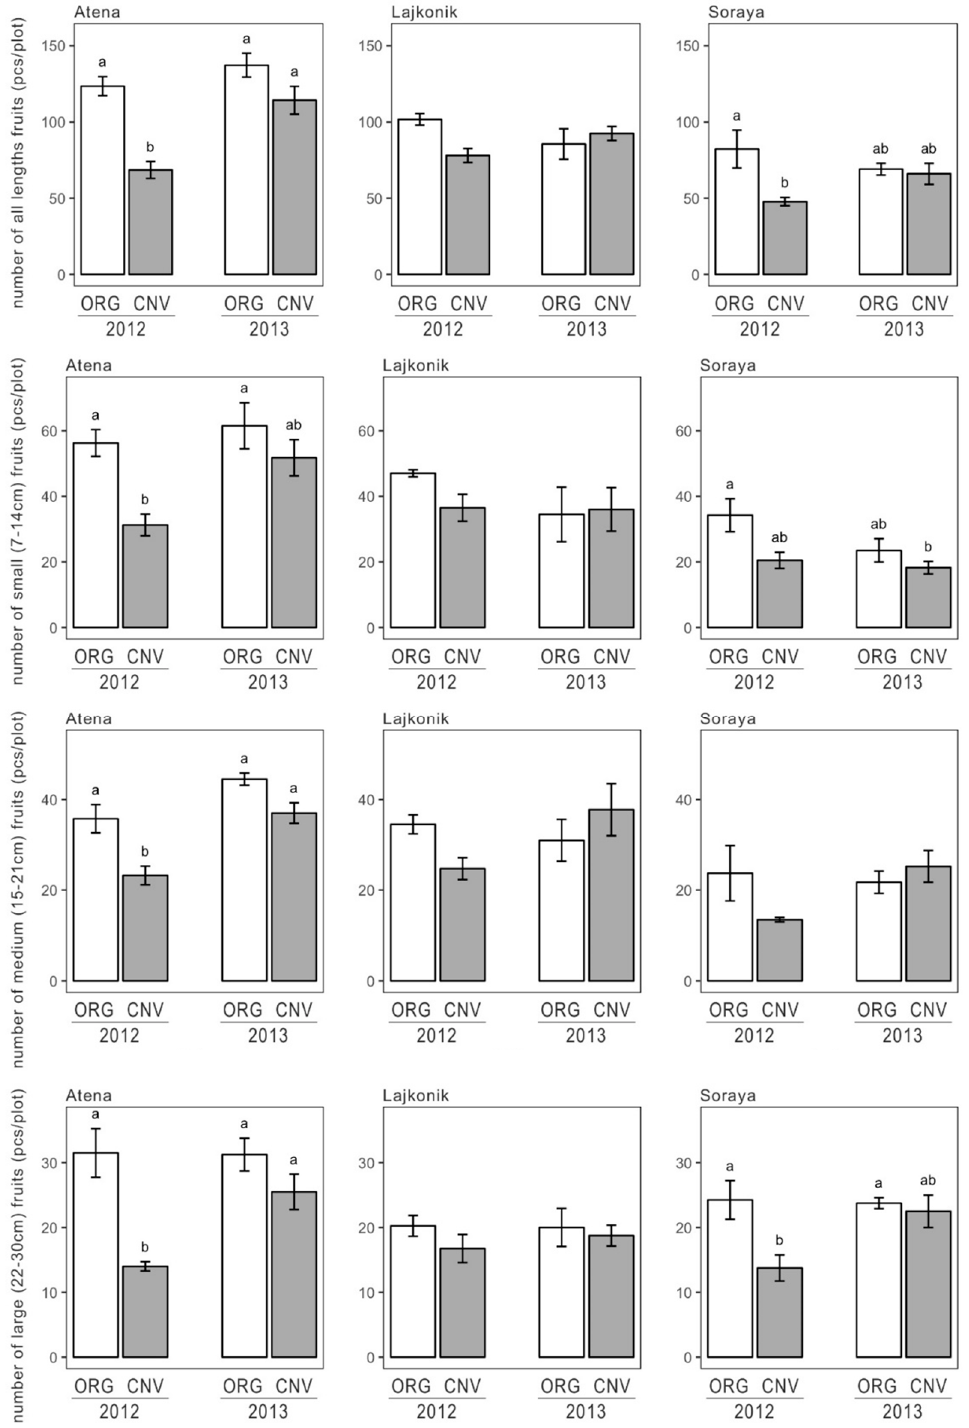
Figure 4. Number (pcs / plot = pcs × 10 3 / ha) of all (7–30 cm), small (7–14 cm), medium (15–21 cm) and large (22–30 cm) organic (ORG) and conventional (CNV) courgette fruits of Atena, Lajkonik and Soraya cultivars grown in two consecutive years. Data are presented as means with standard errors. Within each cultivar, bars marked with the same letters are not significantly different at the 5% level of probability.